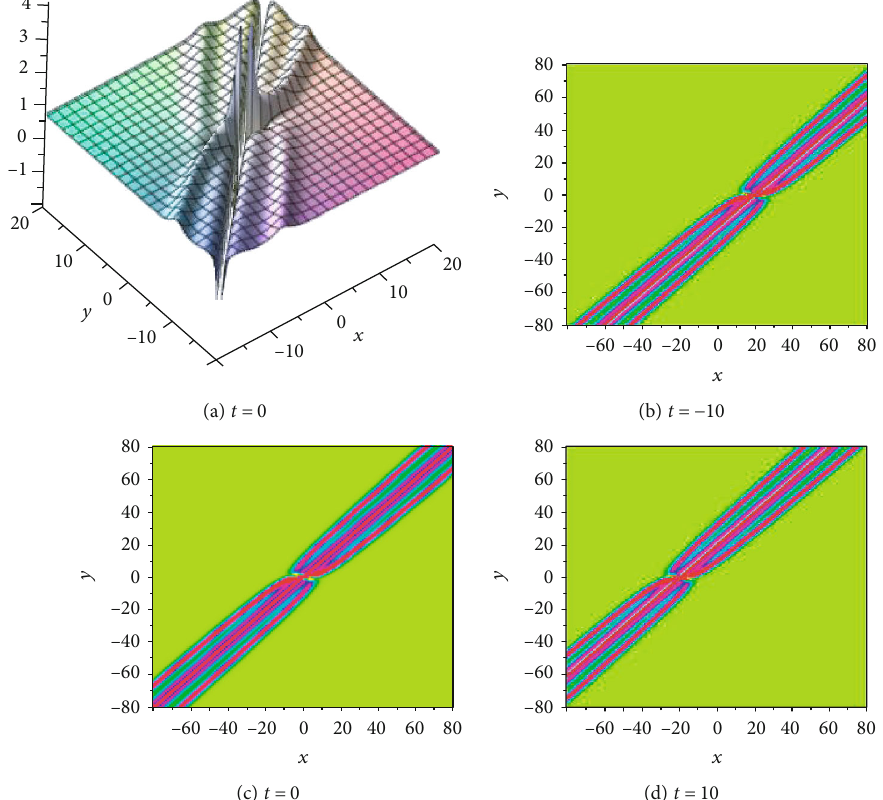
= 1 , k = 1 : 5 , k = 2 , and k = 0 . (a) 1 2 3 4